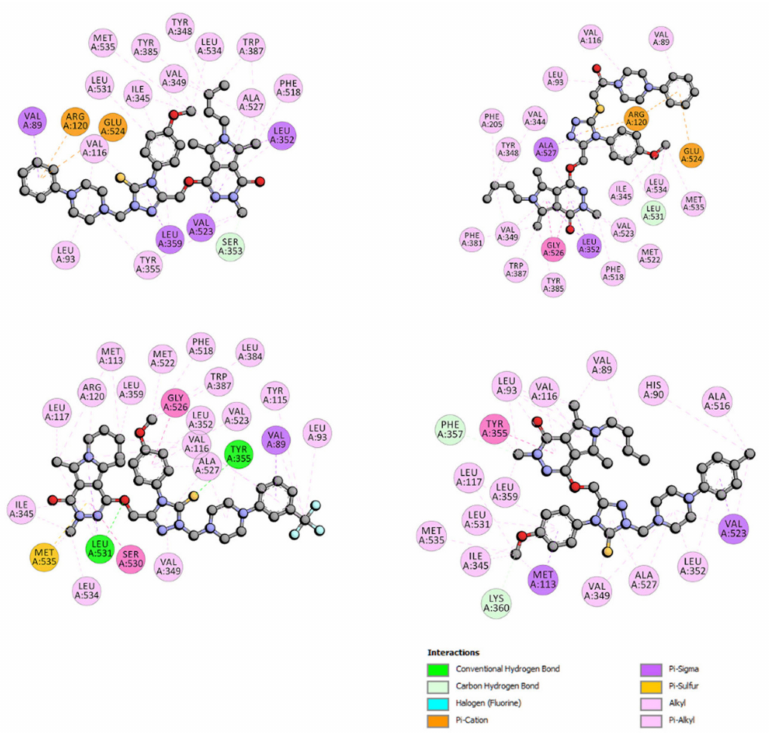
Figure 3. Two-dimensional interaction plot of 4c-7c with COX-2.